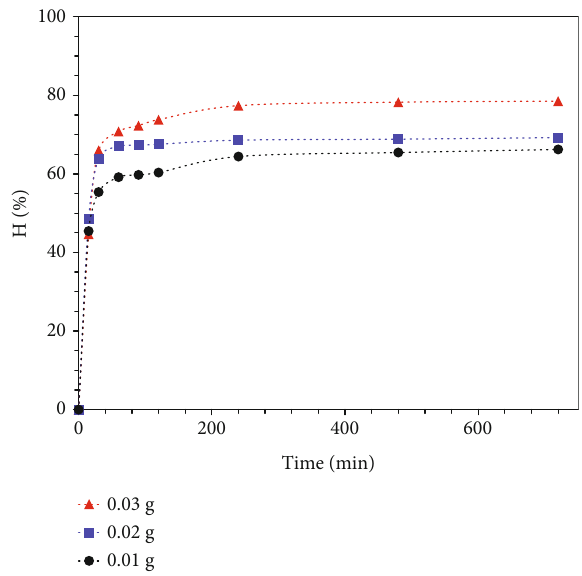
Figure 14: E ff ect of adsorbent dose in MO adsorption onto 2Pan/MHT composite.